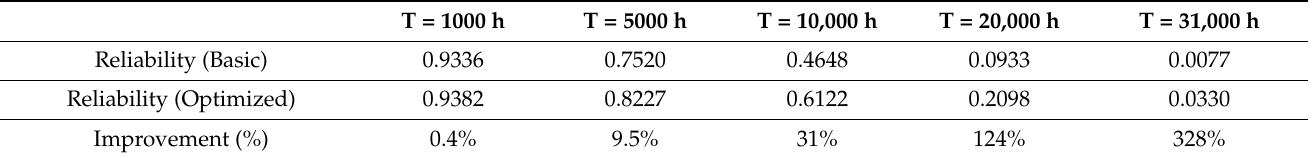
Table 9. Reliability comparison for the basic and optimized